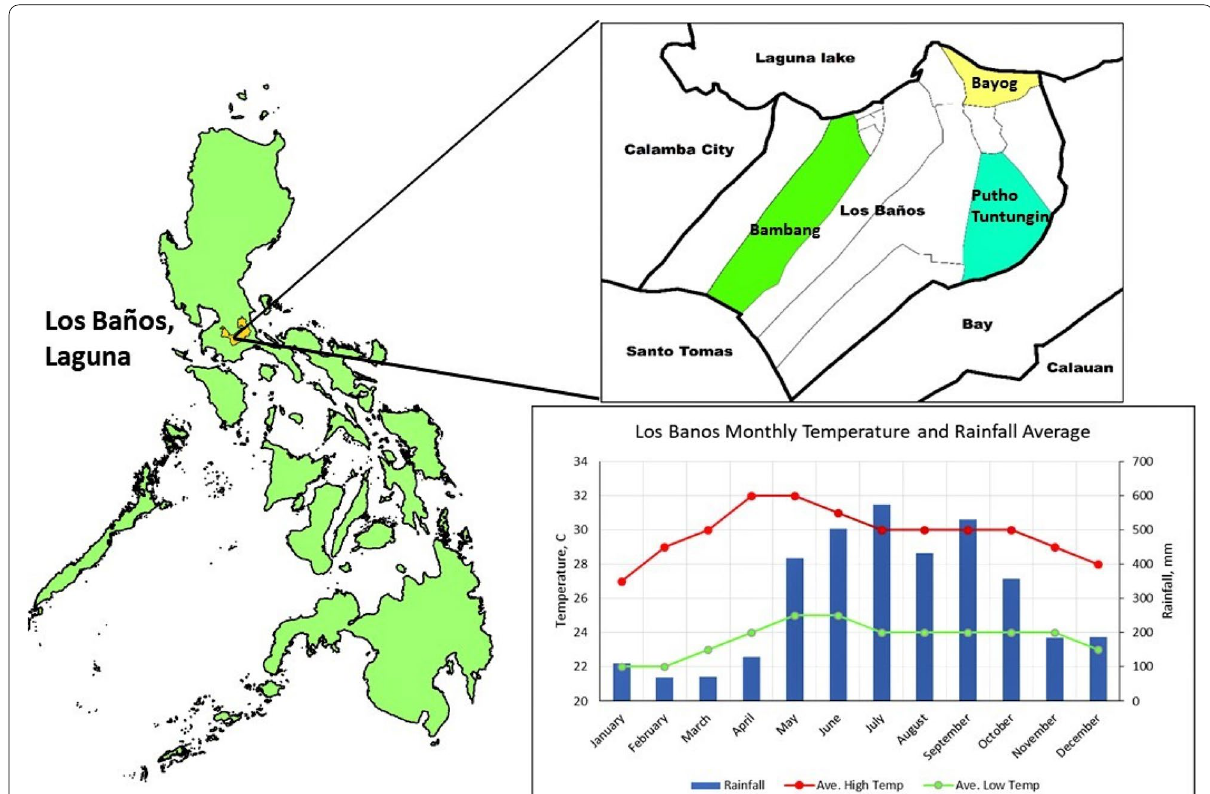
Fig. 1 Geographic Location of Barangays Bambang, Bayog and Tuntungin-Putho. Note : A barangay (village) is considered the smallest administrative district in the Philippines. The bar graph presents the average monthly rainfall while the line graph shows the average monthly high (red line) and low (green line) temperature in Los Baños, Laguna,